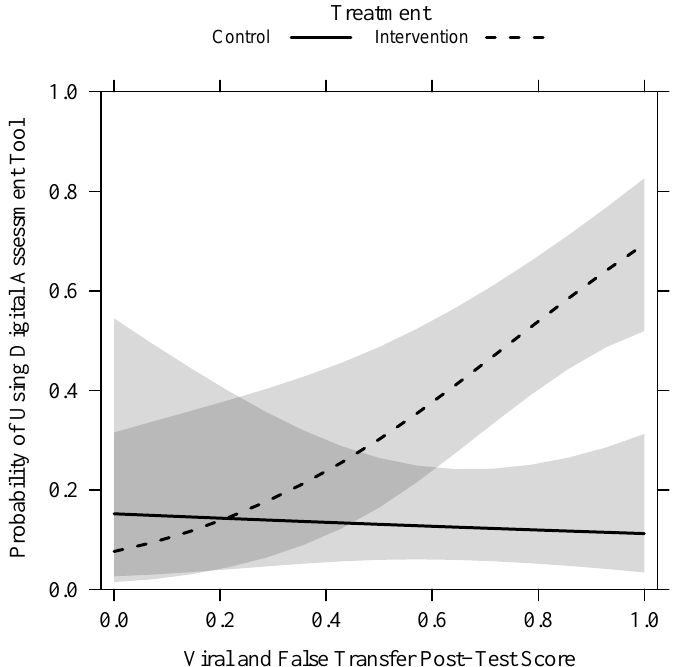
Figure 9. Probability of using digital aids as a function of the viral and false transfer item post-test score and treatment group.